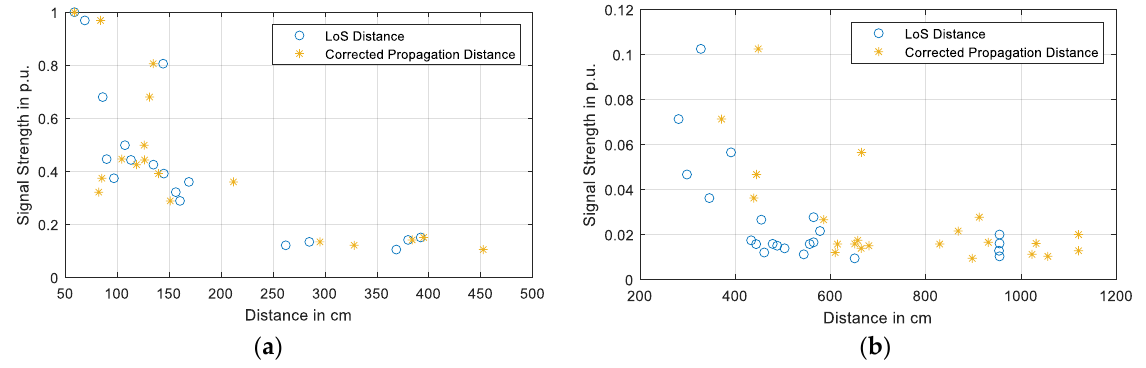
Figure 10. Correction of the propagation distance for signals received from sensor 6: ( a ) direct propagation; ( b ) indirect propagation.